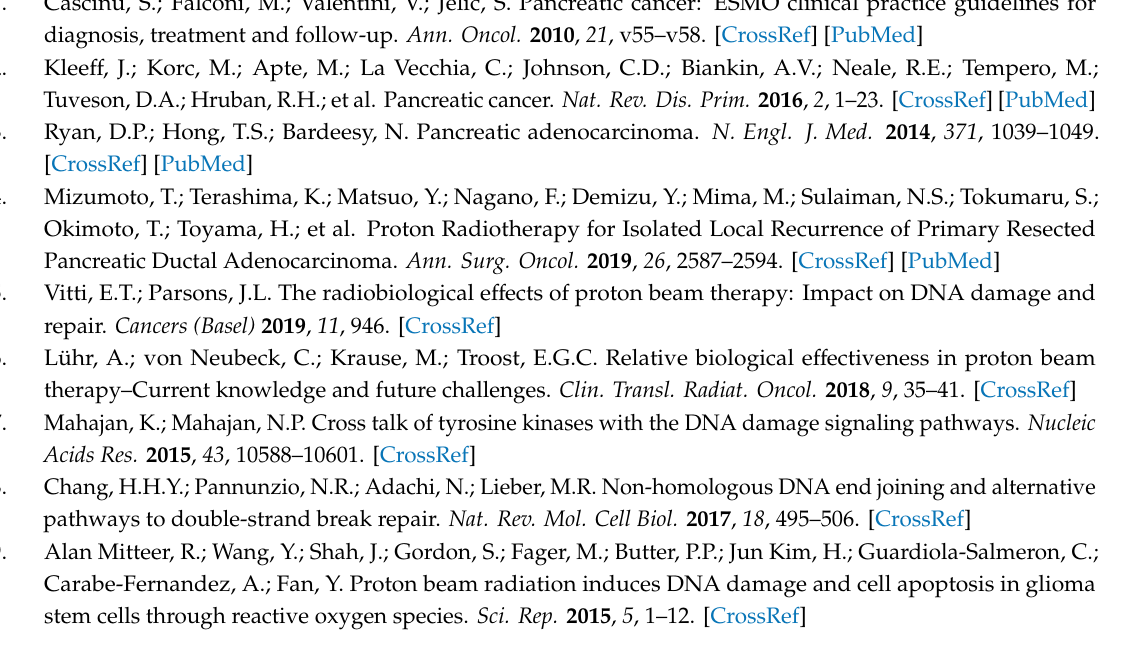
Figure S1: Changes in the phosphoproteome of 3D PDAC cell cultures by proton and photon irradiation, Figure S2: Photon- and proton-irradiated 3D PDAC cell cultures di ff erentially respond to tamoxifen, trastuzumab and prexasertib, Figure S3: Photon- and proton-irradiated 3D PDAC cell cultures di ff erentially respond to lapatinib, Figure S4: Photon and proton irradiation of 3D PDAC cell cultures a ff ect the phosphorylation status of Chk1, ER- α and HER2 di ff erentially. Figure S5: Targeting of signal transduction and DNA repair enzymes in sensitizes PDAC cell cultures to photon and proton irradiation, Figure S6: Targeting NHEJ-associated enzymes seems generally potent to sensitize 3D PDAC cell cultures to photon and proton irradiation, Figure S7: Compilation of uncropped immunoblots for Figure S4A–C, Table S1: RBE values comparing proton to photon irradiation e ff ectiveness in PDAC cell lines, Table S2: SF2 values of PDAC cell lines after photon and proton irradiation, Table S3: Changes in the phosphoproteome of 3D Colo357 cell cultures by proton and photon irradiation, Table S4: Changes in the phosphoproteome of 3D MiaPaCa-2 cell cultures by proton and photon